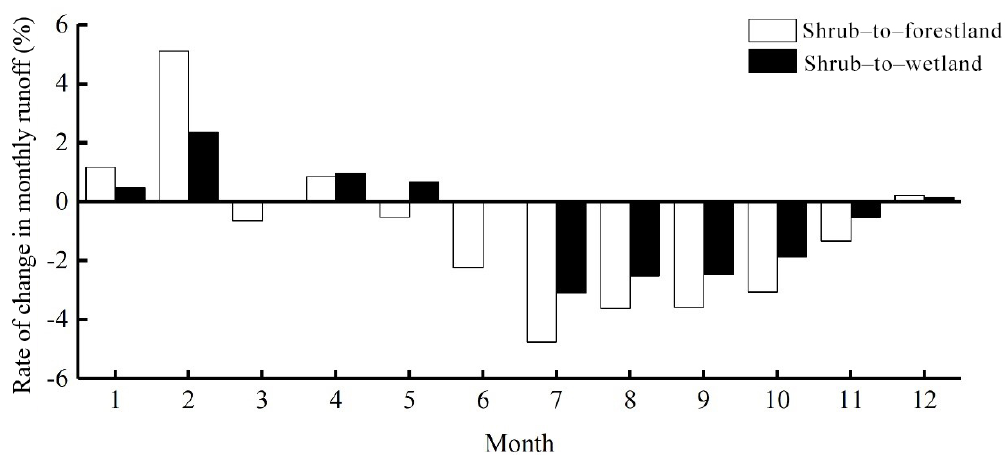
Figure 7. Variation in the rate of monthly runoff in future scenarios.